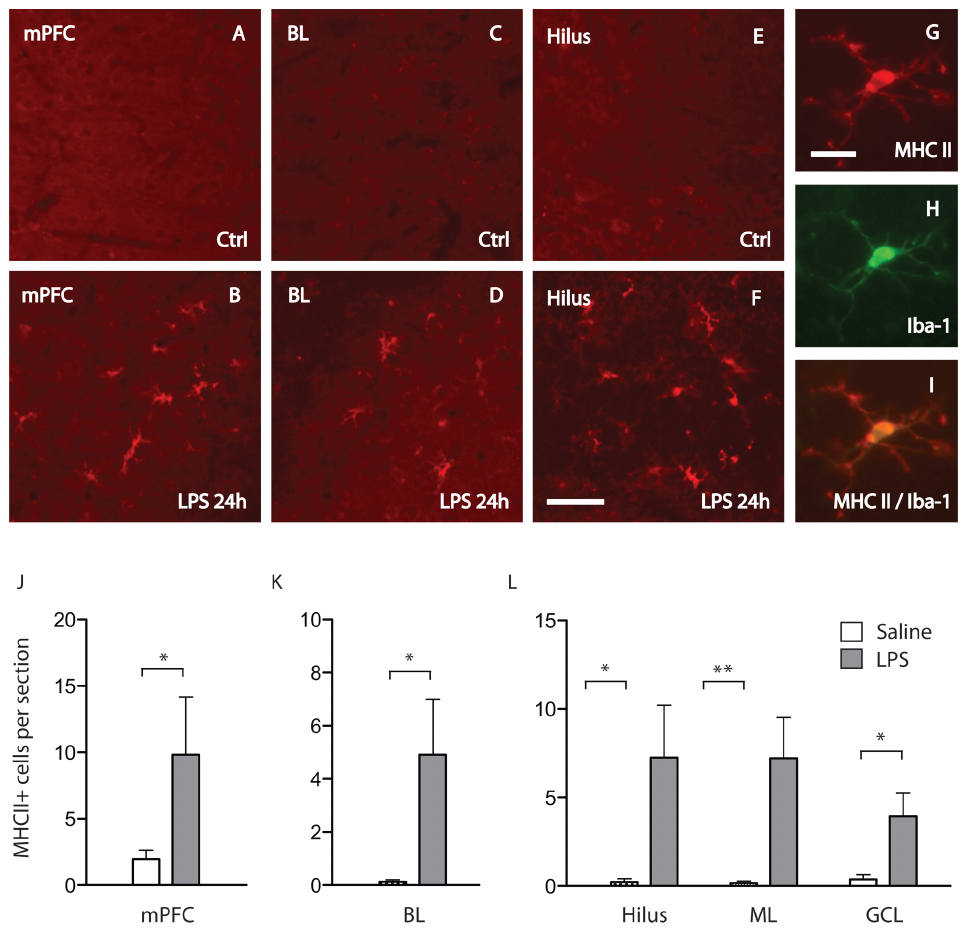
Figure 1. Microglial activity in response to systemic lipopolysaccharide treatment. Images in (A–L) demonstrate immunoflourescence stainings of dendritic MHCII + cells in the medial prefrontal cortex (mPFC), basolateral nucleus of amygdala (BL) and hippocampus (Hilus) 24 hours after LPS treatment (LPS) (B, D, F) and saline treatment (Ctrl) (A, C, E). Scale bar = 80 m m. Images to the right show a microglia double-labeled with antibodies directed towards MHC II (G) and Iba-1 (H). Images (G) and (H) are superimposed in (I). Scale bar=10 m m. Bar graphs in (J-L) show a significant increase in number of dendritic MHCII + cells per section of mPFC (J), BL (K) and Hilus, molecular layer (ML) and granular cell layer (GCL) (L) 24 h after LPS treatment (LPS) compared to saline treatment (Saline). ** indicates a significant difference at p , 0.01 level. * indicates a significant difference at p , 0.05 level.